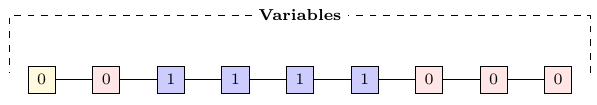
Fig. 2 The feature vector solution